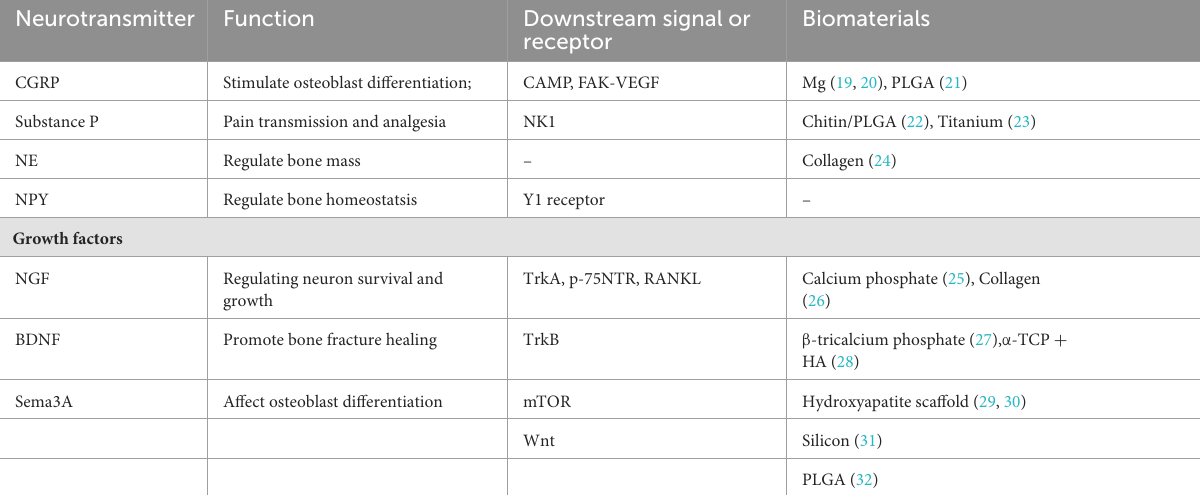
TABLE 1 Molecules and application in tissue engineering.